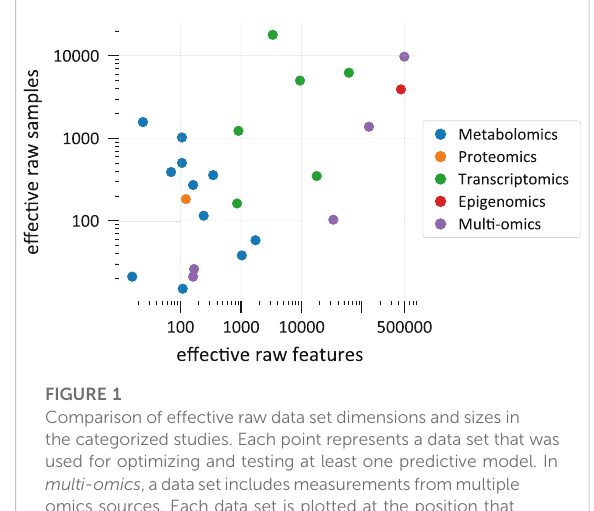
FIGURE 1 Comparison of effective raw data set dimensions and sizes in the categorized studies. Each point represents a data set that was used for optimizing and testing at least one predictive model. In multi-omics ,adatasetincludesmeasurementsfrommultiple omics sources. Each data set is plotted at the position that correspondstoitseffectiverawdimensionandsize.Pleasereferto the main text for explanations on the meaning of effective raw featureandsamplecounts(Section2.1).Notethatthegraphshows only a selection of all ML-ready data sets from all studies. Supplementary Figure S1 provides references to the shown data